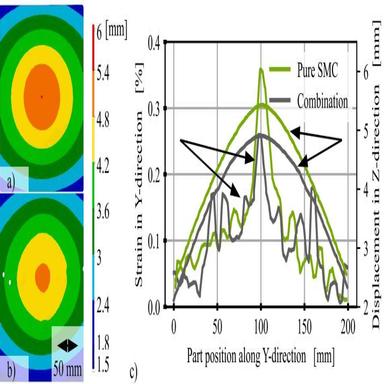
Experimentally determined displacement map in ROI 4 of the pure SMC part (a) and combined towpreg design (b) on the 3D part, with strain and displacement distribution along the Y-direction in the middle of ROI 4 (c).